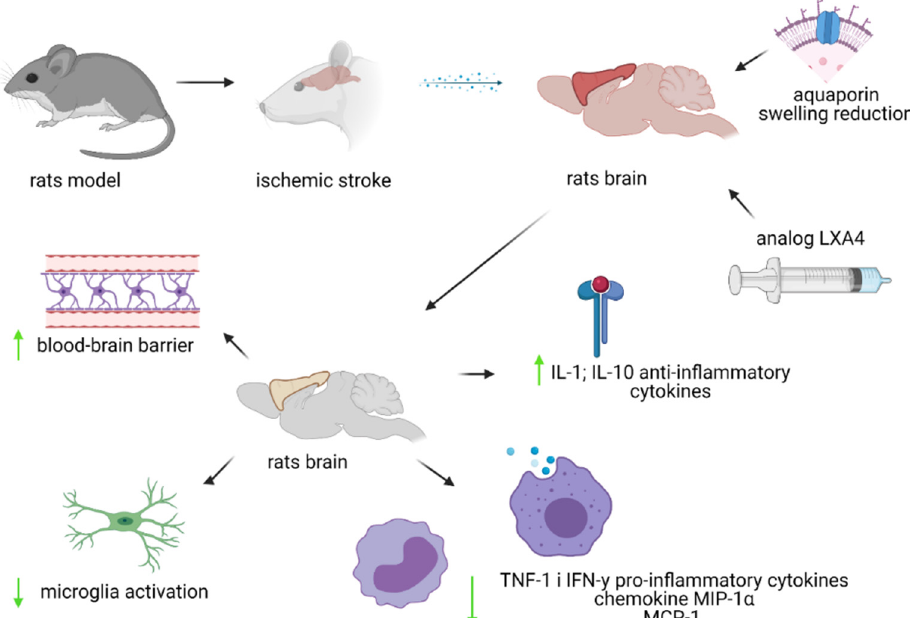
Figure 2. Diagram of the influence of the LXA4 analogue on ischemic stroke in the rat model. IL-1 and IL-10—interleukein 1 and 10; TNF-1—tumor necrosis factor- α ; IFN- γ —interferon gamma; MIP-1 α —macrophage inflammatory protein-1 α ; MCP-1—monocyte chemotactic protein-1.